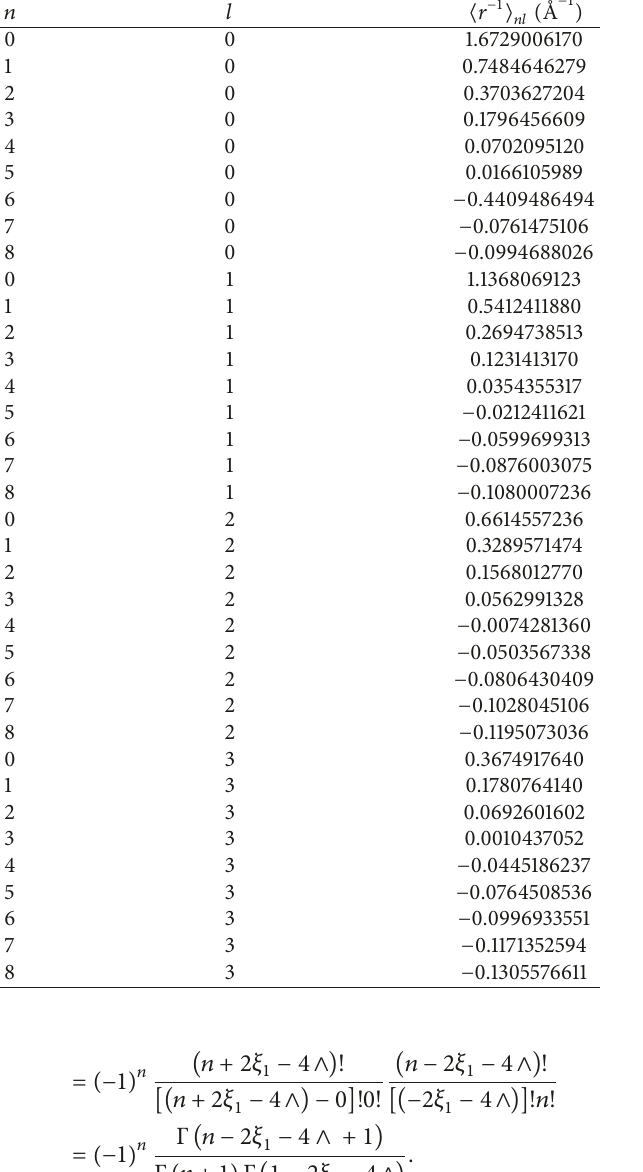
Table 8: Expectation values of ⟨𝑟 −1 ⟩ for hydrogen chloride molecule. Table 9: Expectation values of ⟨𝑟 −1 ⟩ for carbon ( 11 ) oxide